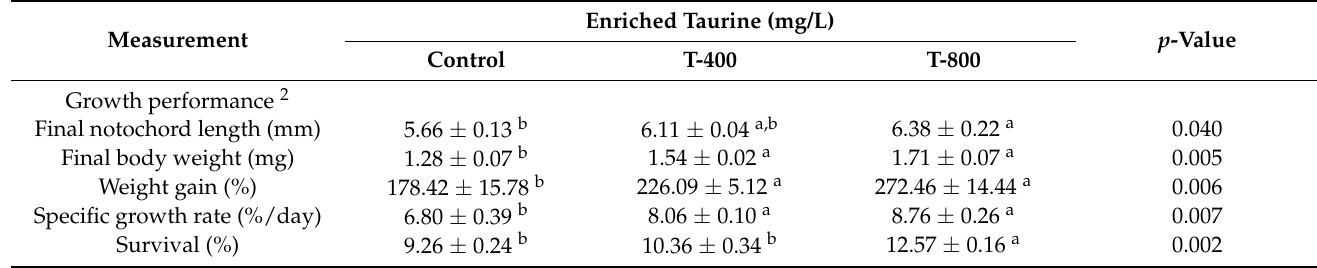
Table 3. Growth performance of yellow croaker larvae fed with the various taurine-enriched rotifers for 15 days 1